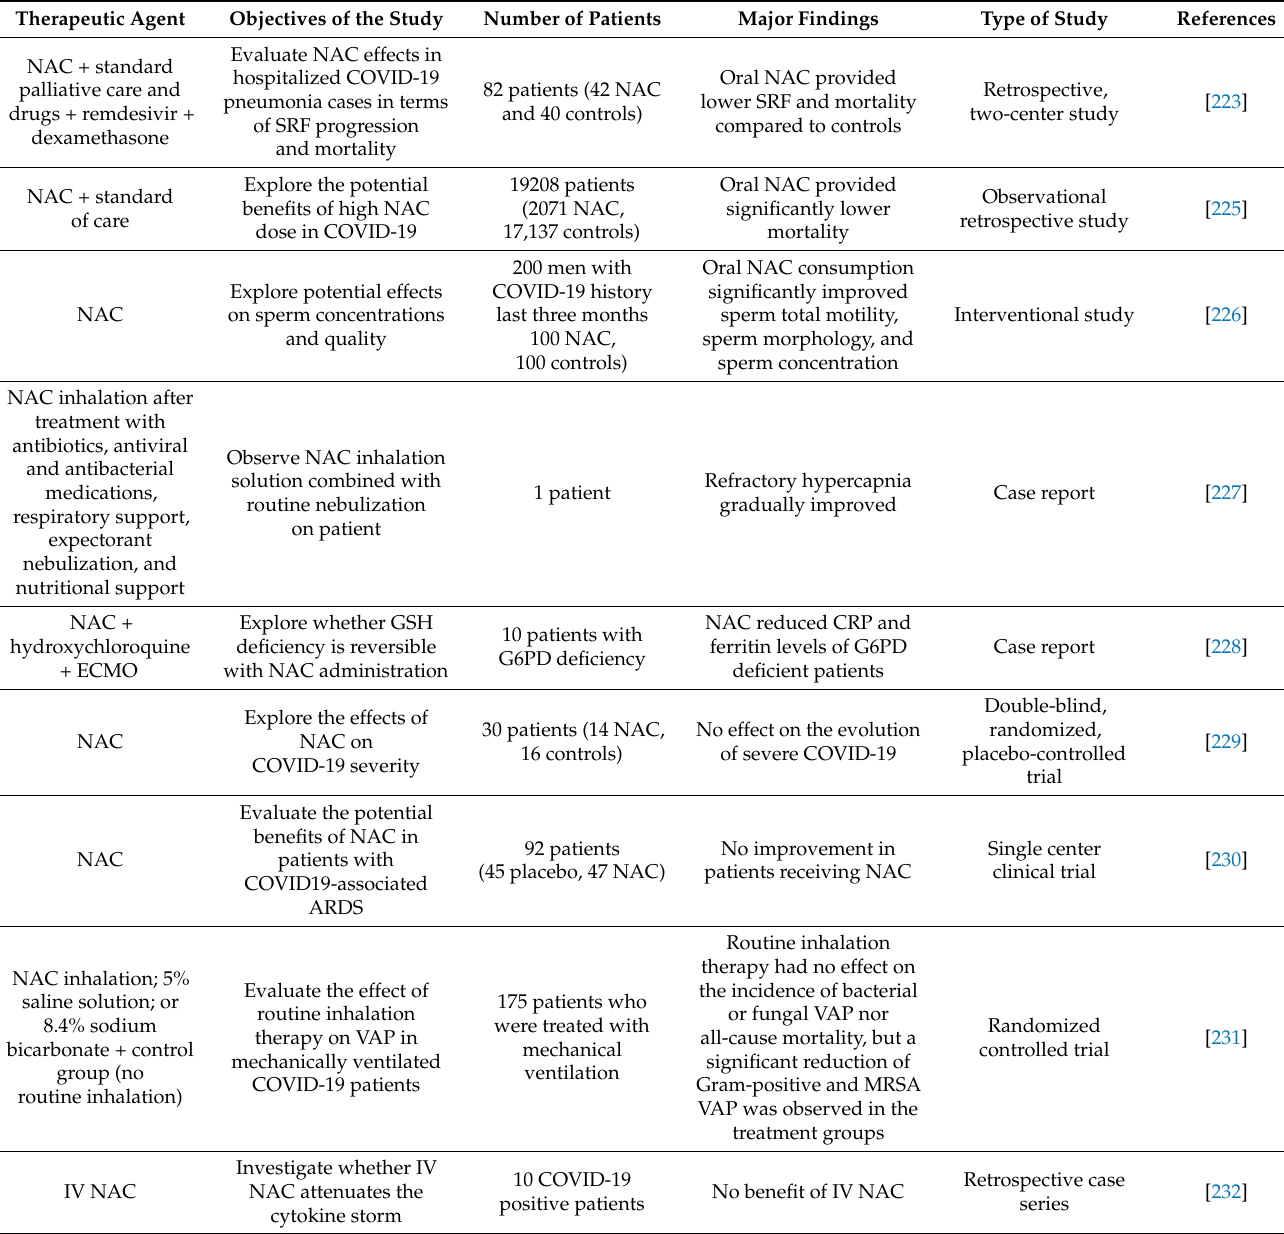
Table 6. Published studies on NAC administration in COVID-19